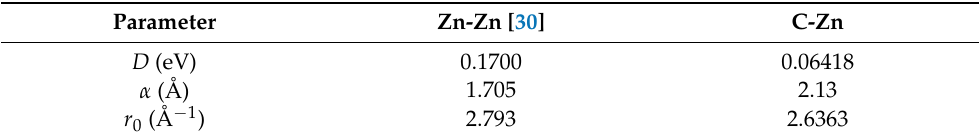
Table 4. Morse potential